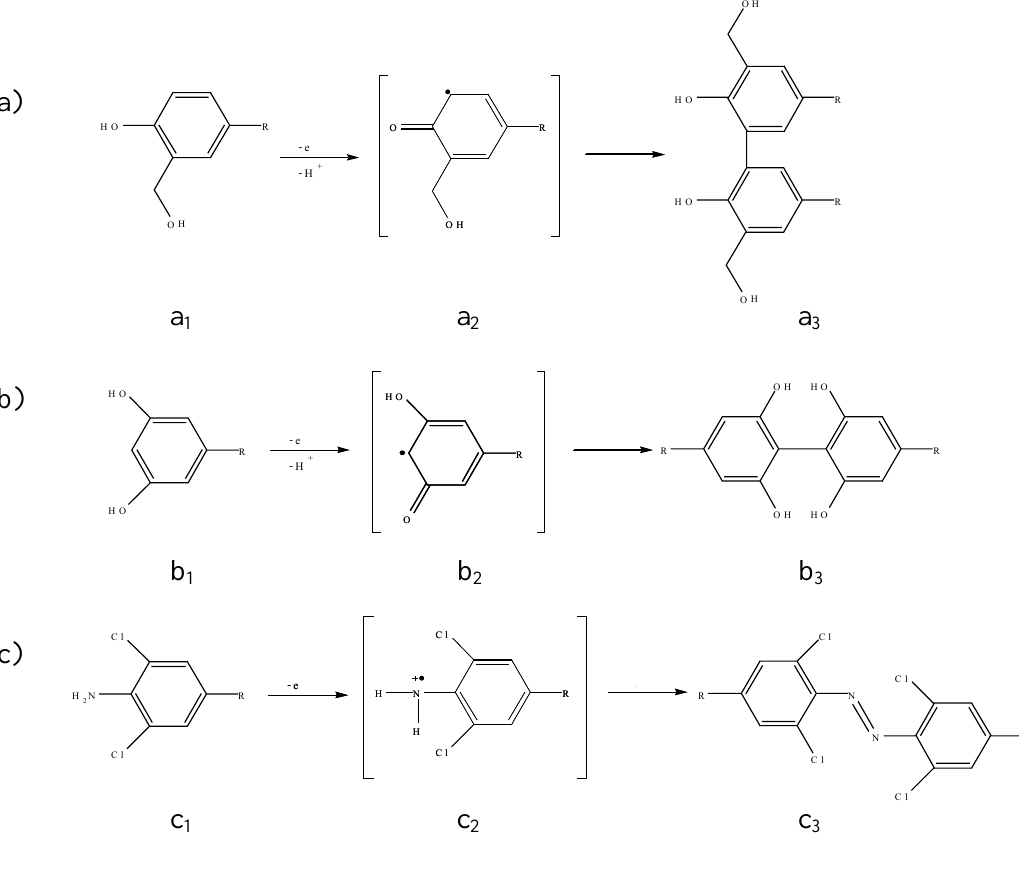
Figure 1. The structures and oxidation reactions of the three β -agonists: (a) Salbutamol (b) Terbutaline (c) Clenbuterol, and their reduced (a oxidized (a